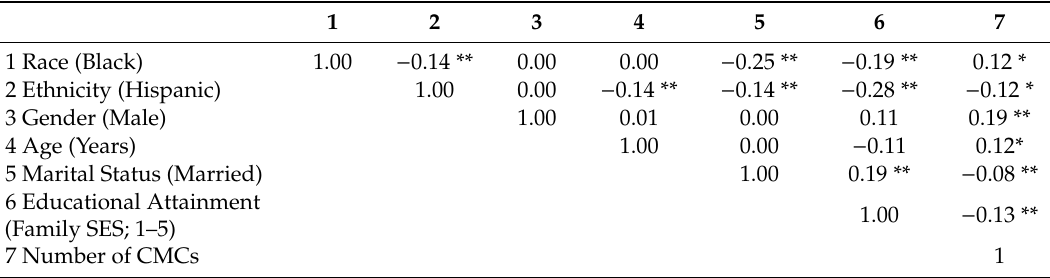
Table 2. Bivariate correlations in the overall sample.